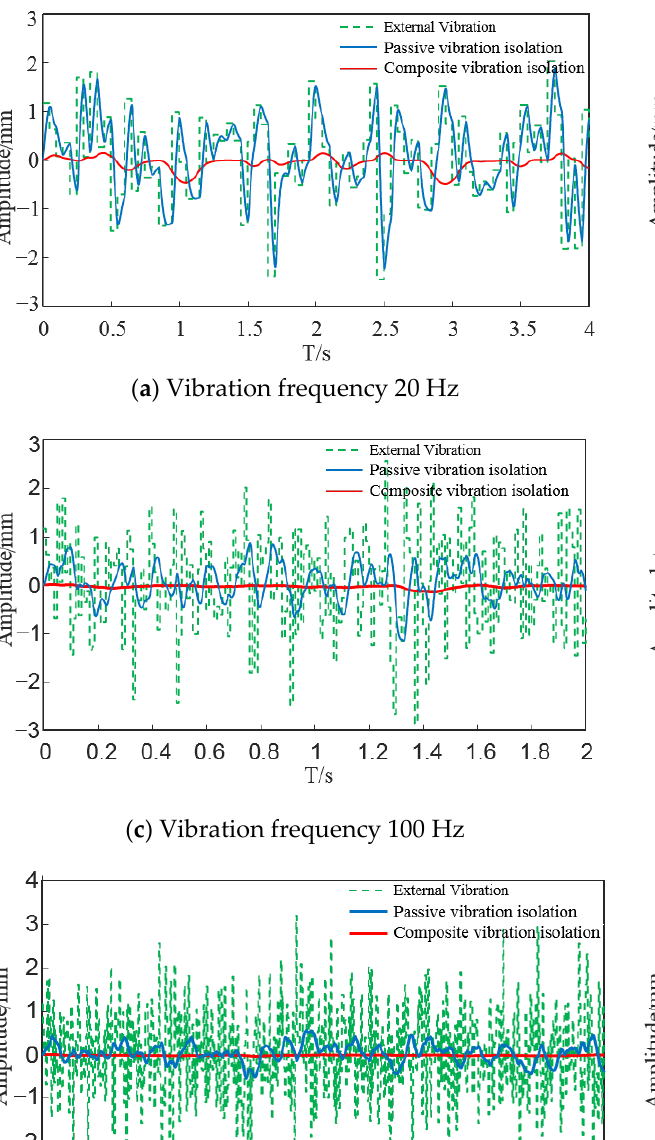
Figure 13. Vibration isolation effect.